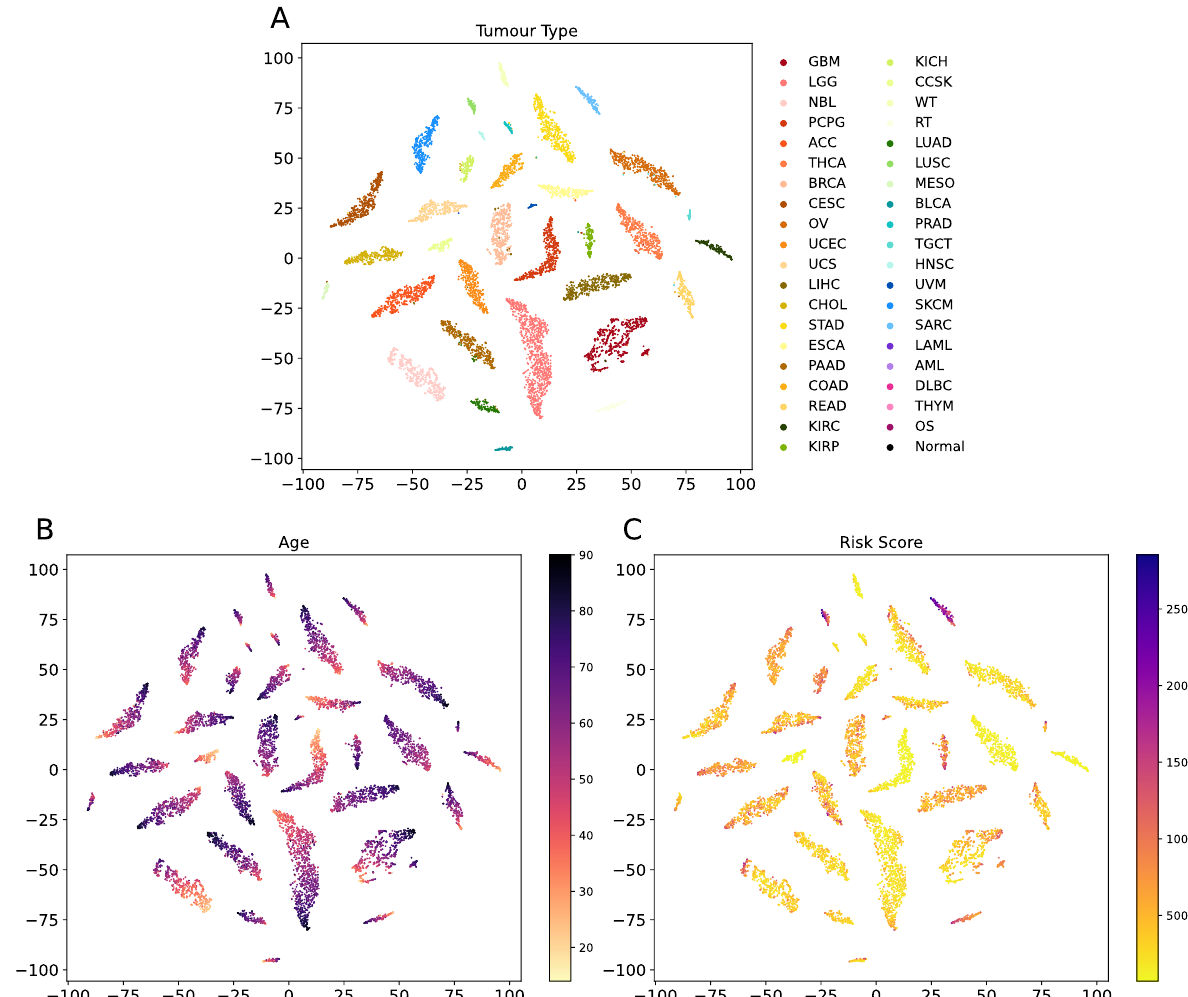
Figure 8. Visualisation of the latent space learnt by the multi-task OmiEmbed. Each sample was colour by its tumour type ( A ), age ( B ) and risk score ( C ) in three corresponding scatter graphs with the same latent representation. Apparent patterns related to the three types of labels can be seen in the scatter